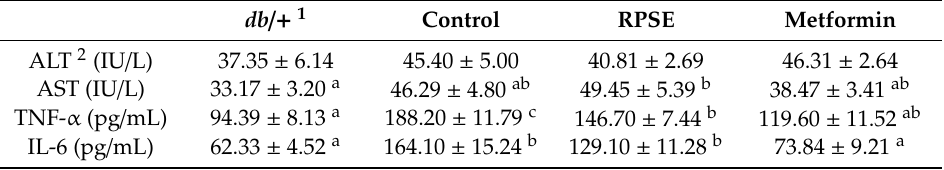
Table 3. Hepatic function and the pro-inflammatory cytokines in db / db mice. db /+